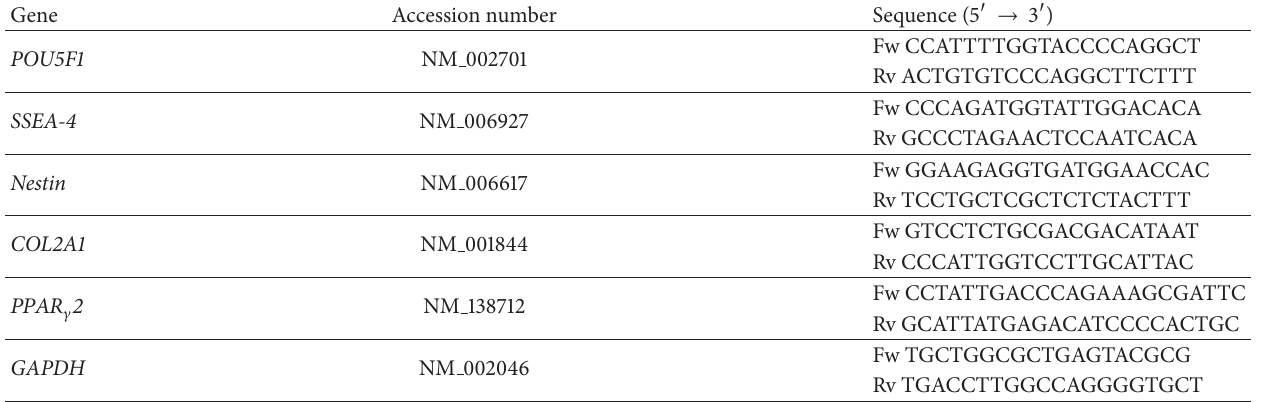
Table 1: The primers